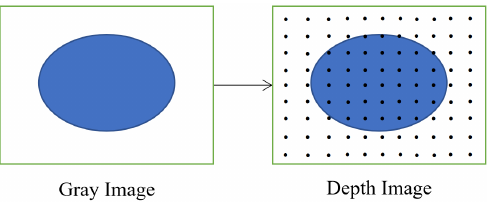
Figure 9. Gray image and depth image correspond to the same area. The circle feature point cloud extracted by the result of gray image ellipse detection contains not only the circle feature but also other interferences, such as the installation surface of the circle feature, and the false detection of the circle area because of the shadow area of a small part of the